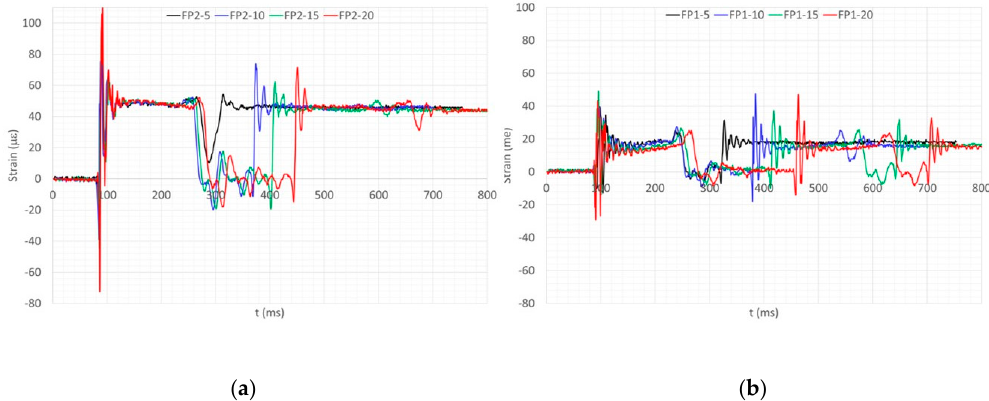
Figure 18. Occurrences recorded by the two FBGs bonded to the impact plates during the four drop tests. ( a ) FP1 (right plate) and ( b ) FP2 (left plate). The drop from h = 0.05 m is represented by a black line, from h = 0.10 m is in blue, from h = 0.15 m is in green, and from h = 0.20 m is in red.